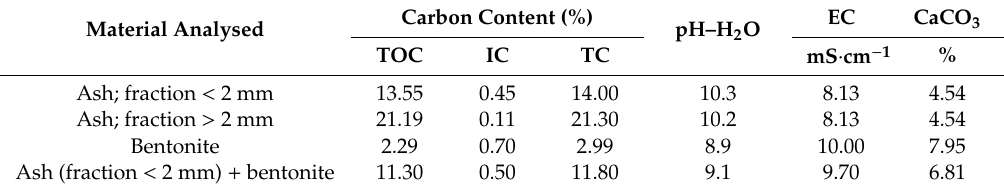
Table 4. Basic physical and chemical properties of the ashes, the bentonite and the granulate produced from